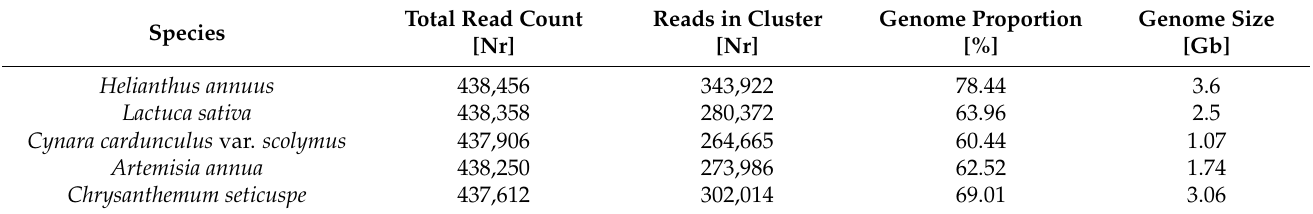
Table 2. Total read count, number of clustered reads and corresponding genome proportion for each species, as obtained by the comparative analysis of hybrid clustering